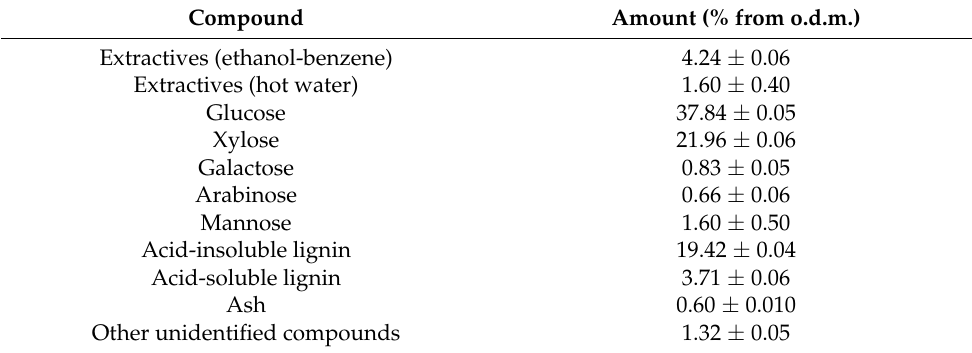
Table 3. Chemical composition of BWCs.